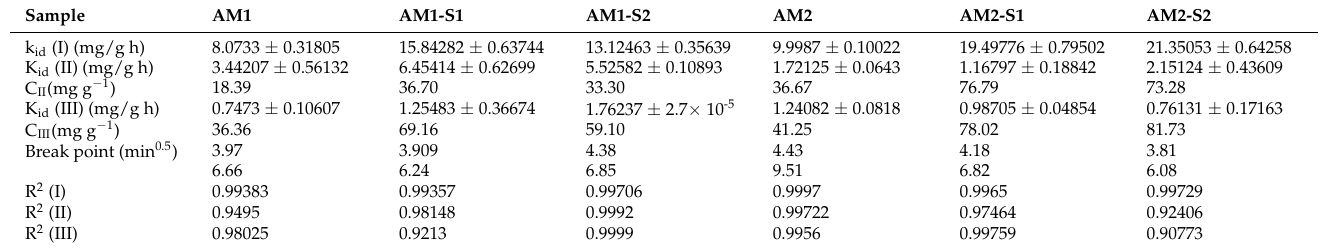
Figure 8. Dark adsorption ( a , b ) and adsorption capacity of MB on AM(1/2)-S(1/2) NPs vs. √𝒕 ( c , d ) (c(MB) = 5 mg/L, V = 25 mL of MB solution and w(AM(1/2)-S(1/2) = 0.040 g at room temperature). Table 2. Intraparticle diffusion kinetic parameters (q t = k id t 0.5 +C) of MB adsorption onto AM(1/2)- S(1/2) NPs (linear